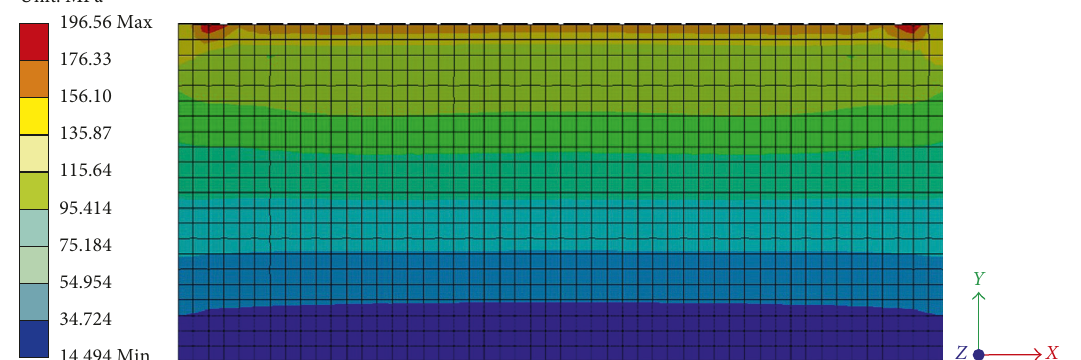
Figure 7: Map of Max Principal Stress distribution in the joint for the computational time equal to 0.0001s, under normative loading (Figure 2(a)).